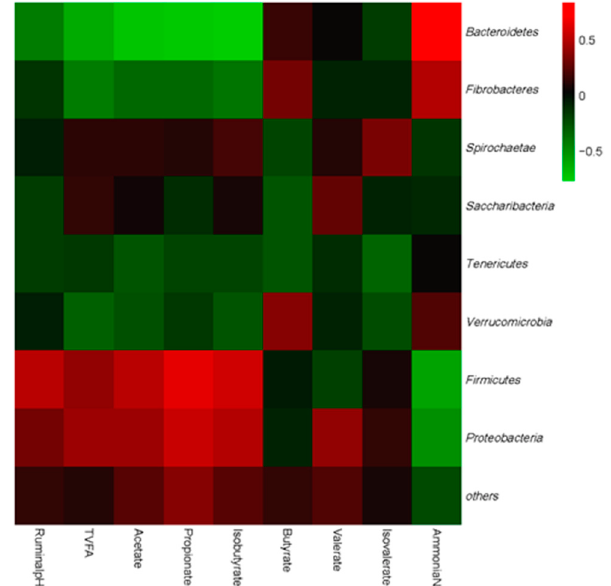
Figure 3. Correlation analyses between abundances of ruminal bacteria and DMI, milk quality parameters, and ruminal fermentation parameters on the level of phyla. The red color represents a positive correlation while the green color represents a negative correlation.